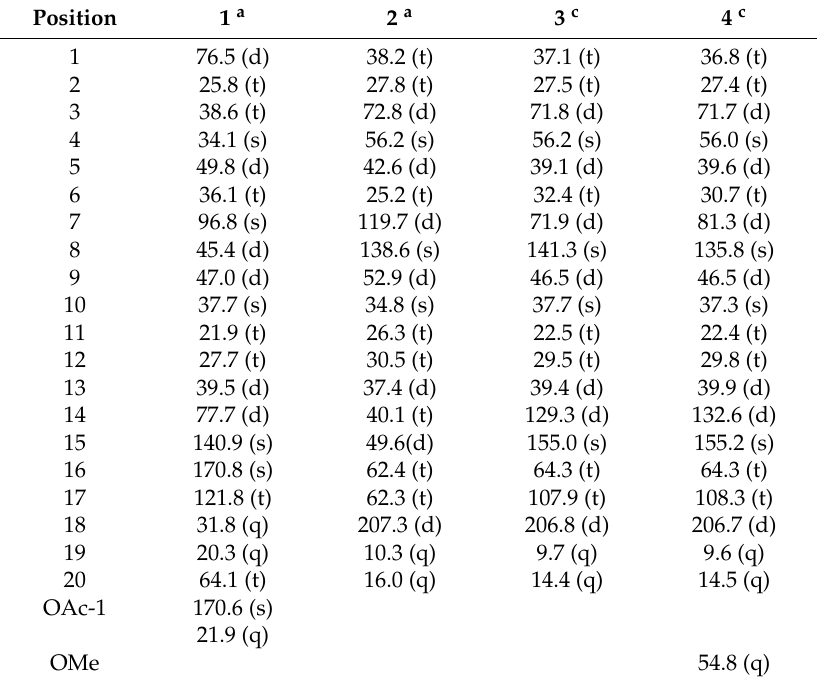
Table 2. 13 C-NMR spectroscopic data for compounds 1 – 4 in pyridine- d 5 ( δ in ppm). Position 1